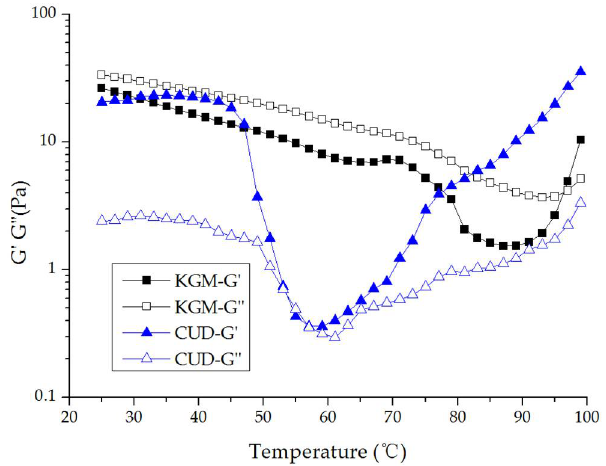
Figure 4. Curves showing the variation in G’ and G” for KGM and CUD with increasing temperature during the heating process.